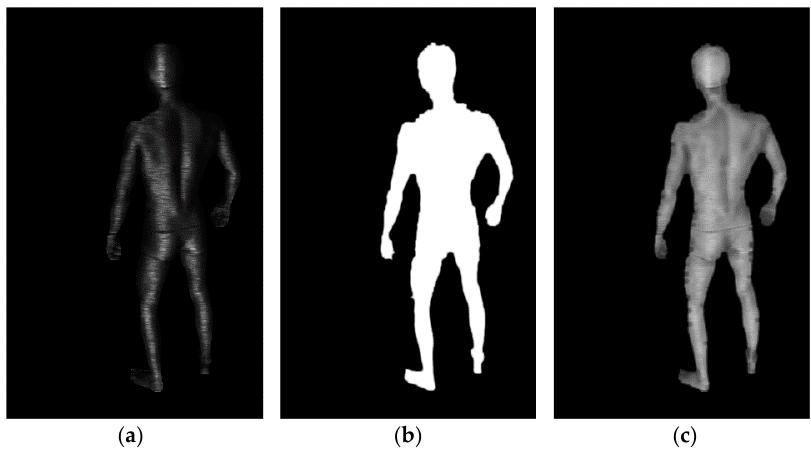
Figure 8. Example images showing the ( a ) Vm and ( b ) Bm calculation results and ( c ) Qm calculated based on the Vm and Bm, together with the Am and Sm.